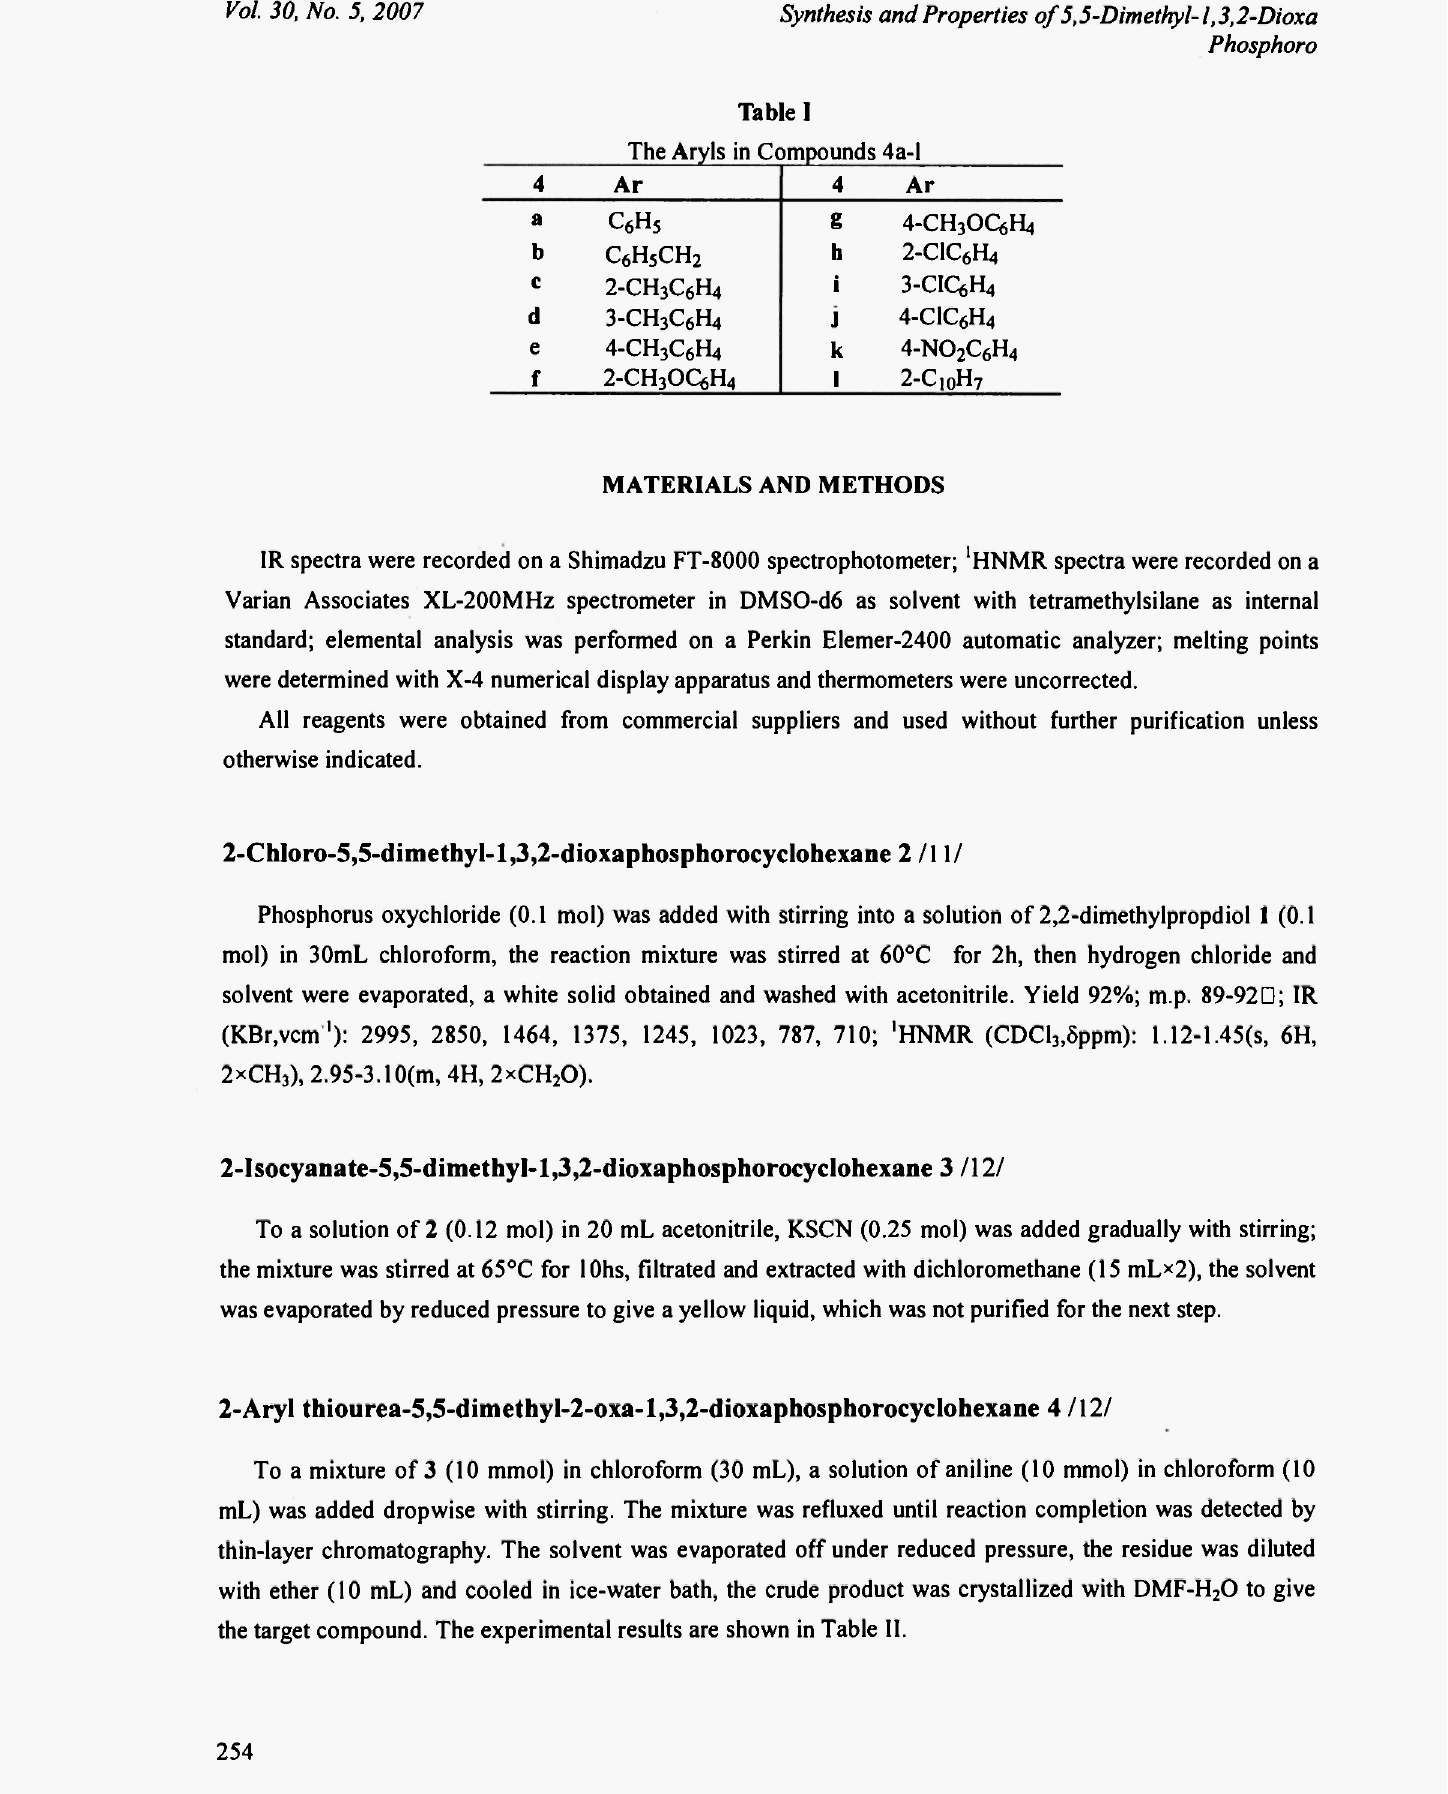
The Aryls in Compounds